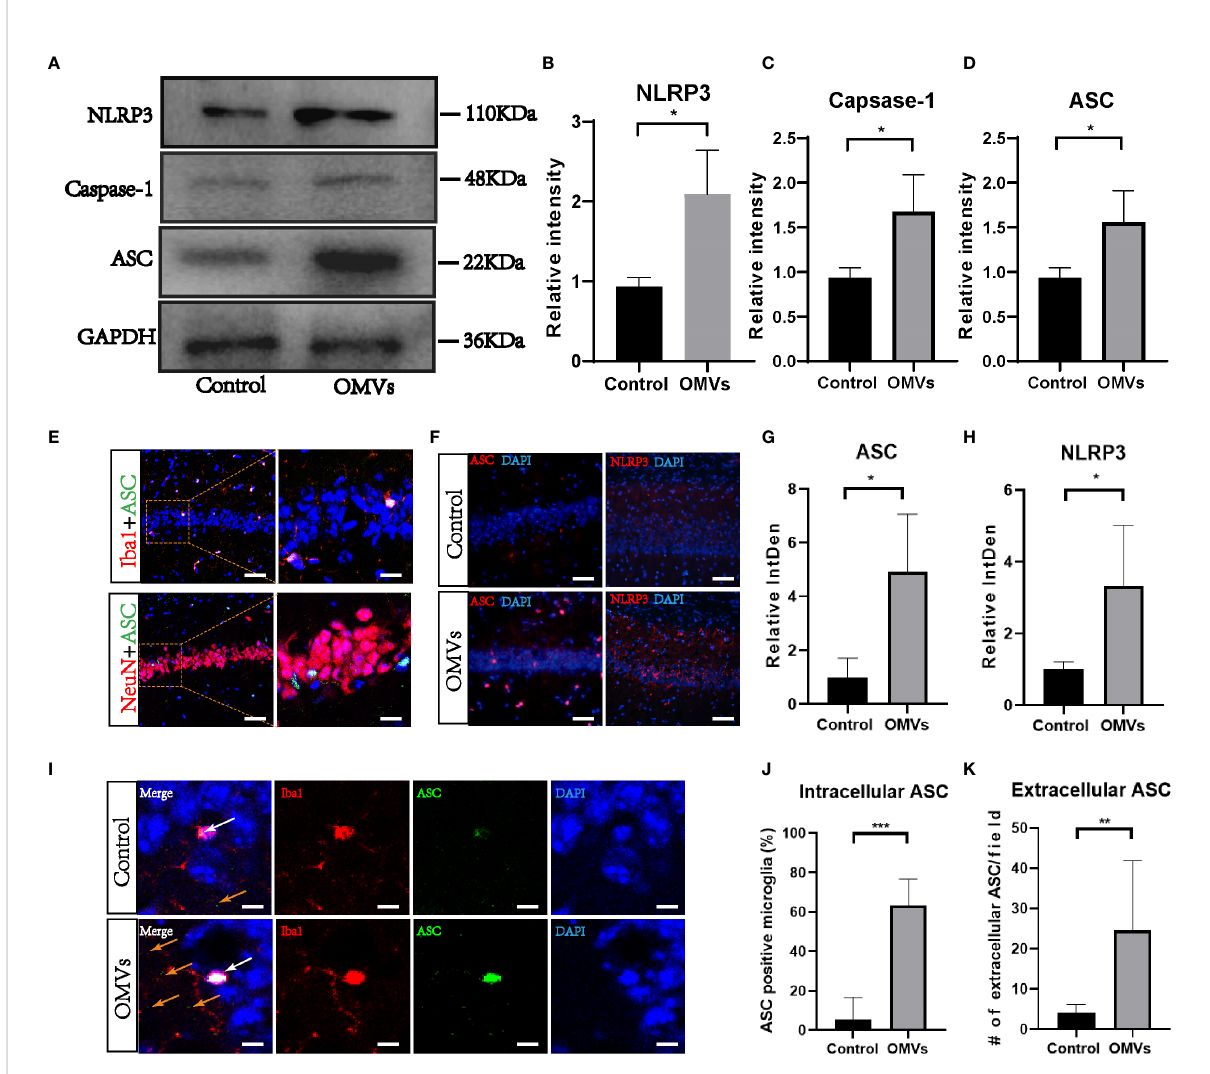
FIGURE 8 Oral gavage of Pg OMVs triggers NLRP3 in fl ammasome in the hippocampus of mice. (A) The Western blots showed NLRP3, caspase-1, and ASC in the hippocampus of mice. (B – D) The quantitative analyses of immunoblots in image (A) ( n = 3, * p <.05). (E) Co-localization of ASC with neuronal cell marker (NeuN) and microglia marker (Iba1) revealed expression of ASC in microglia but not in neurons, scale bar left = 50 m m, scale bar right = 20 m m. (F) Immuno fl uorescent images showed ASC (red) and NLRP3 (red) expression in hippocampus of mice, scale bar = 50 m m. (G, H) The quantitative analyses of immunoblots in image (F) ( n = 3, * p <.05) (I) Immuno fl uorescent images showed intracellular ASC (white arrow) and extracellular ASC (yellow arrows) in hippocampus of mice. Scale bar = 5 m m. (J) The percentage of intracellular ASC positive microglia in hippocampus of mice, counted from fi ve slides per mouse and expressed as means ± SEM; n = 4 mice/group. ( n = 4, *** p <.001) (K) Number of extracellular ASC per fi eld in hippocampus of mice. ( n = 4, ** p